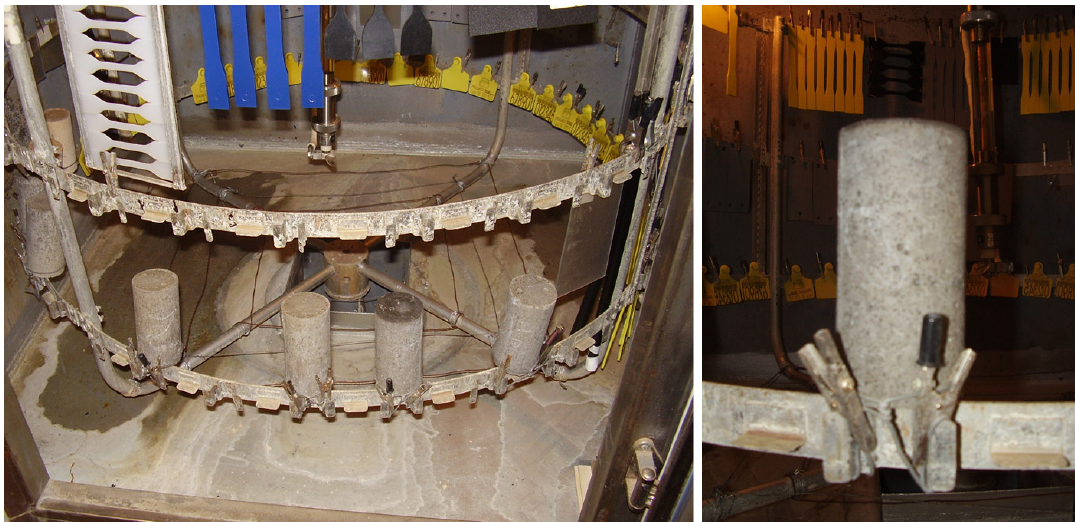
Figure 4. Position of the samples in the accelerated aging